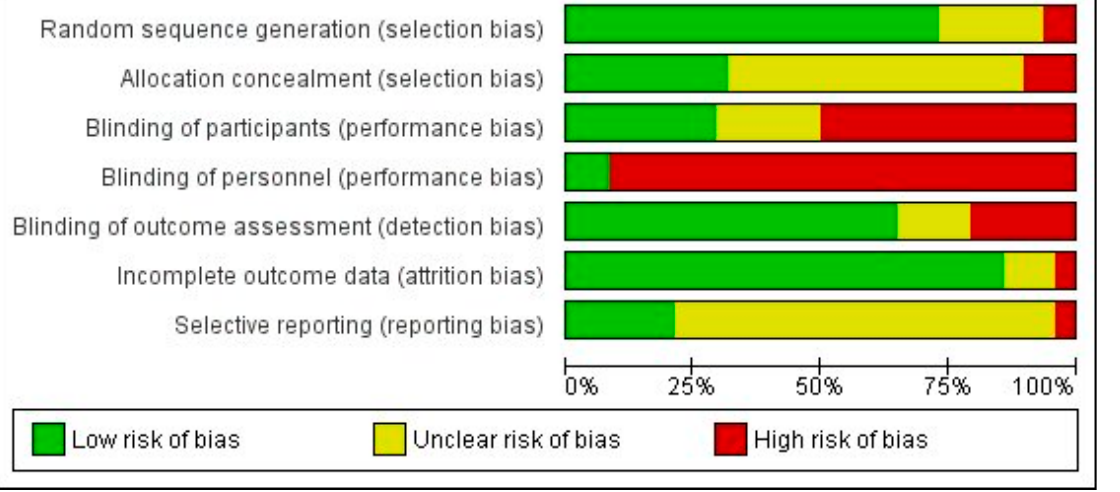
Figure 2. Risk of bias graph: review authors’ judgements about each risk of bias item presented as percentages across all included studies .